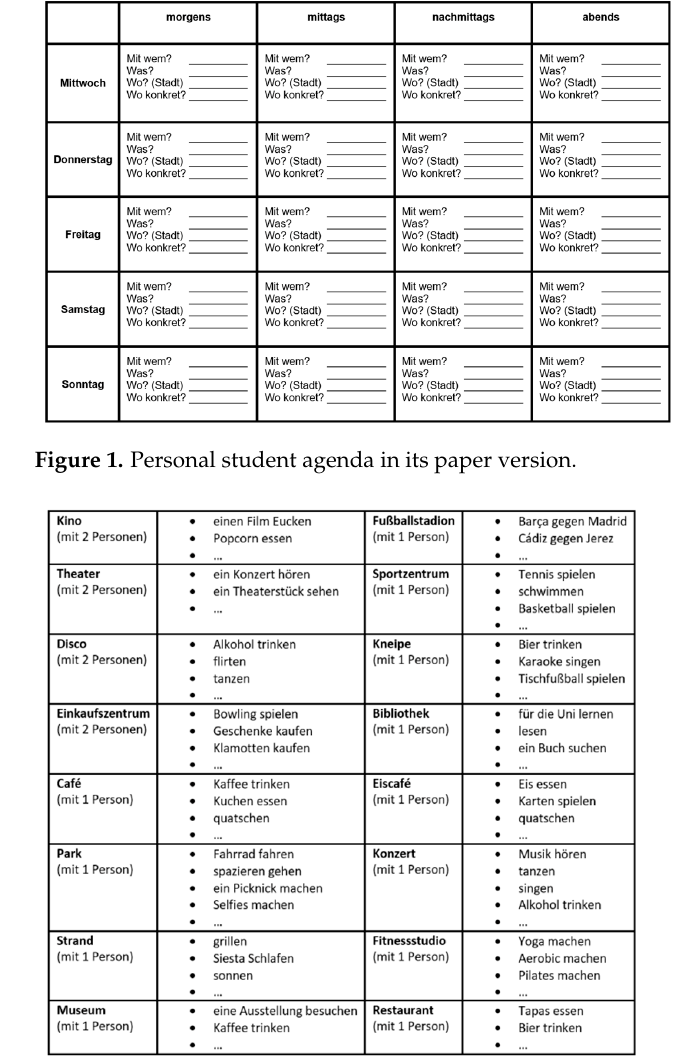
Figure 2. Worksheet for the paper version with the list of activities to do.